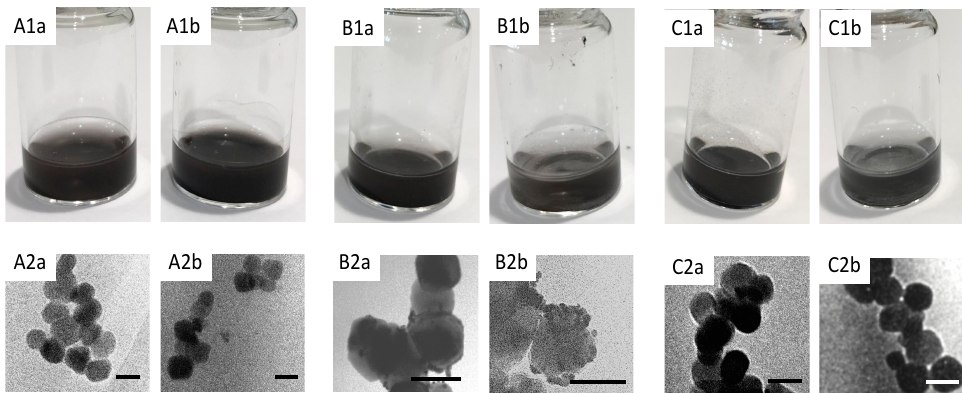
Figure 3. Images of ( A ) Fe 3 O 4 -PEI, ( B ) Fe 3 O 4 -PEI-Au seeds and ( C ) HNPs produced via a: standard methodologies and b: microfluidic manufacture as showing physical form in 1: photograph and 2: transmission electron micrograph (line denotes 50 nm scale). Table 1. Hydrodynamic diameter and metal content analysis of the hybrid nanoparticles.